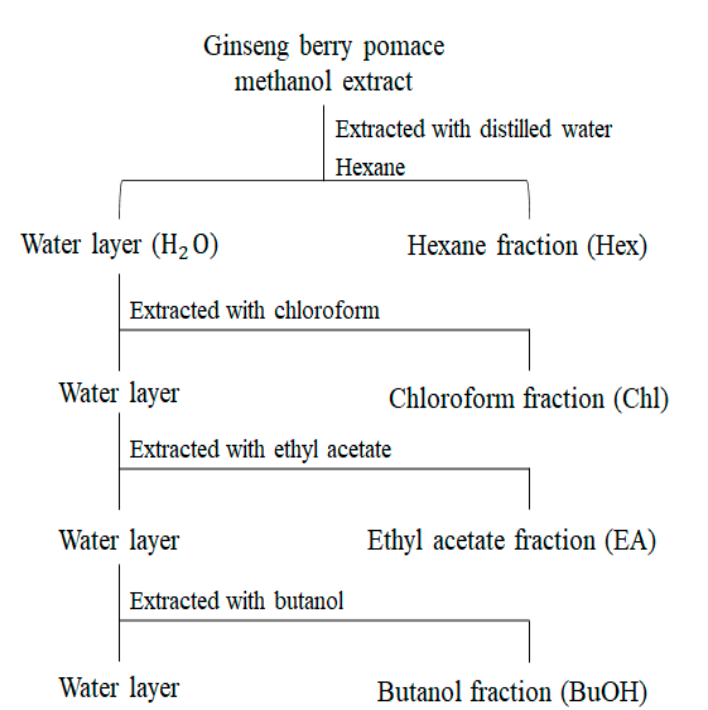
Figure 4. Flow chart of solvent–solvent extraction of GBP fractions with various solvents.